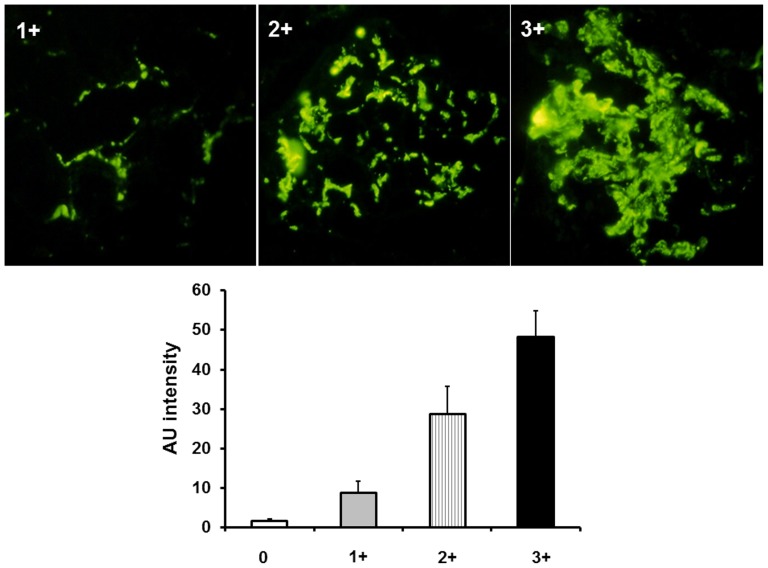
Representative pictures of immunofluorescence staining of mesangial C3 1+ to 3+.Immunofluorescence intensity was quantified by ImageJ software.